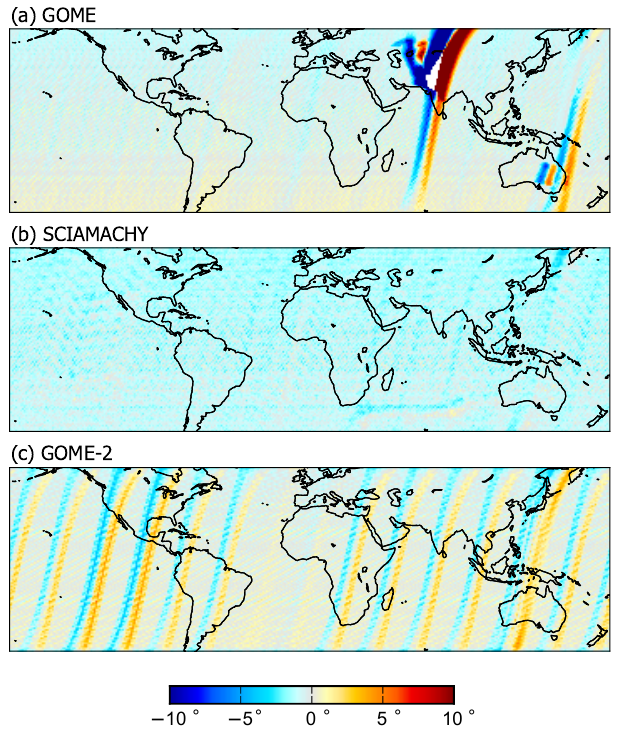
Figure B1. Mean scan angle averaged over the complete time series for GOME (a) , SCIAMACHY (b) , and GOME-2 (c) . Back scans as well as orbits in NSM have been skipped. See text for details.